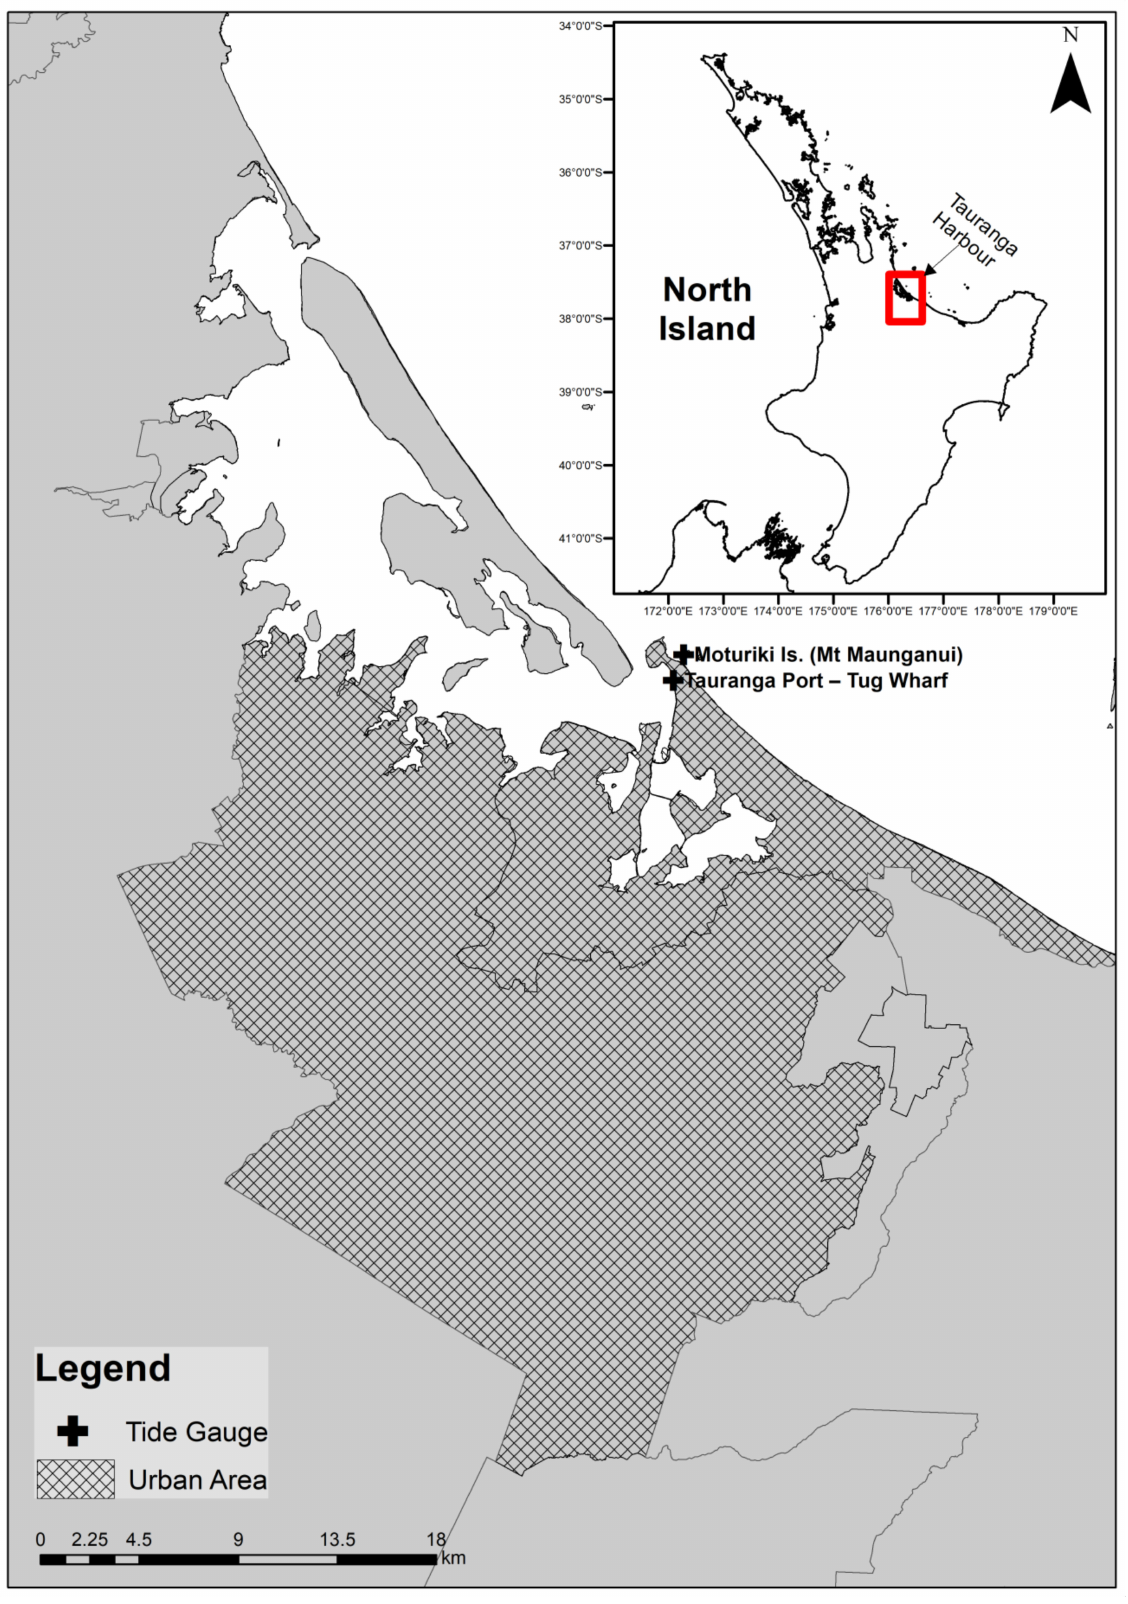
Figure 1. Location of Tauranga Harbour, New Zealand, also showing the Tauranga City urban area boundary and the location of the Moturiki Island tide gauge outside the Harbour and the Tauranga Port tide gauge within the lower